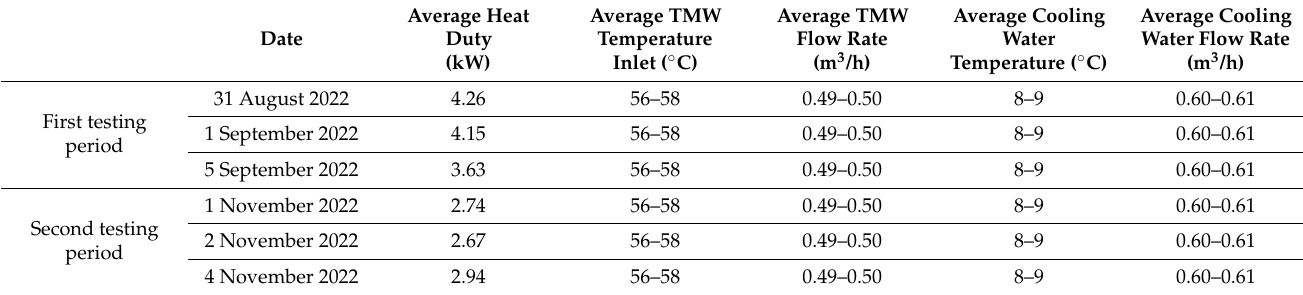
Figure 9. HEX-1 TMW cumulative flow rate during experiment. Table 6. Comparison of HEX-1